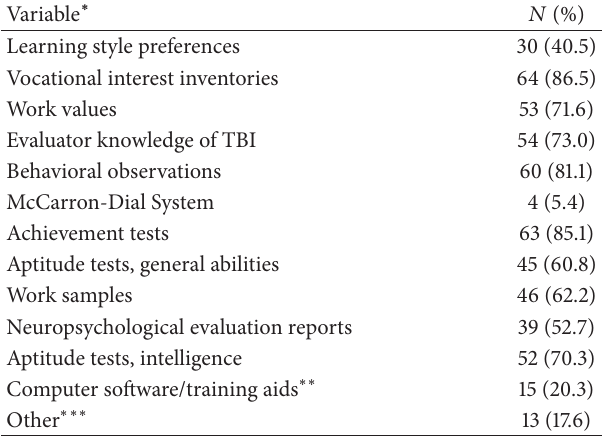
Table 3: Tools/assessments/techniques used in vocational evalua- tion.